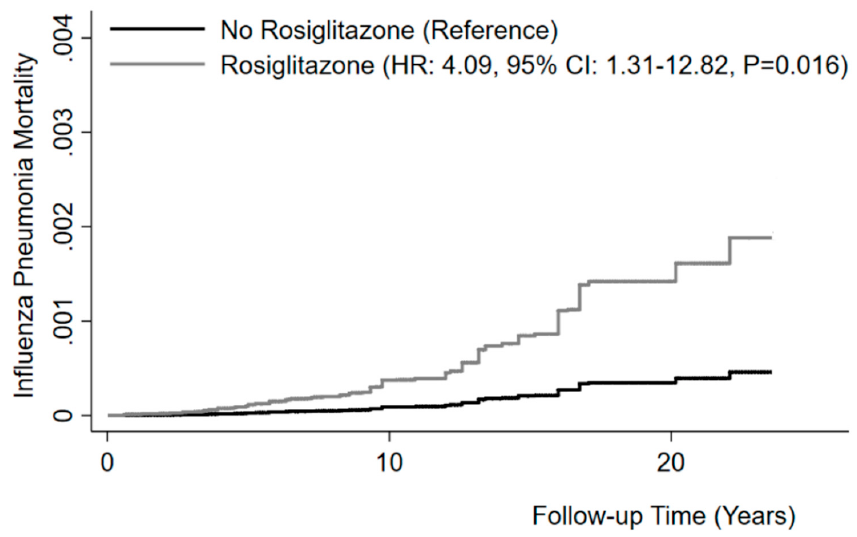
Figure 1. Rosiglitazone and risk of mortality from influenza / pneumonia. Kaplan–Meier curves for cumulative mortality from influenza / pneumonia in non-users and users of rosiglitazone. Model adjusted for age, gender, race / ethnicity, PIR, cigarette smoking, asthma or COPD, treatment by insulin, and treatment by other oral antidiabetic drugs. Model also accounting for competing risk of mortality from causes other than influenza and